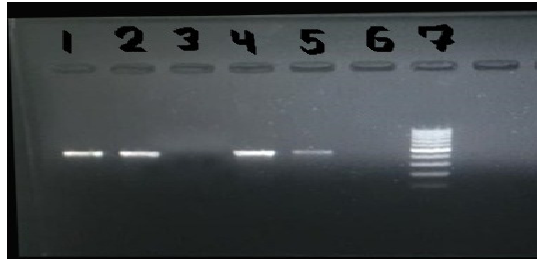
Figure 2. DNA gel electrophoresis showing virulence gene bands of P. aeruginosa . Lanes 1 and 2 show two isolates expressing the 433 bp lasB gene; Lane 3 shows the negative control; Lanes 4 and 5 show two isolates expressing the 454 bp toxA gene; Lane 6 shows the toxA negative control; and Lane 7 shows a 100 bp DNA ladder.